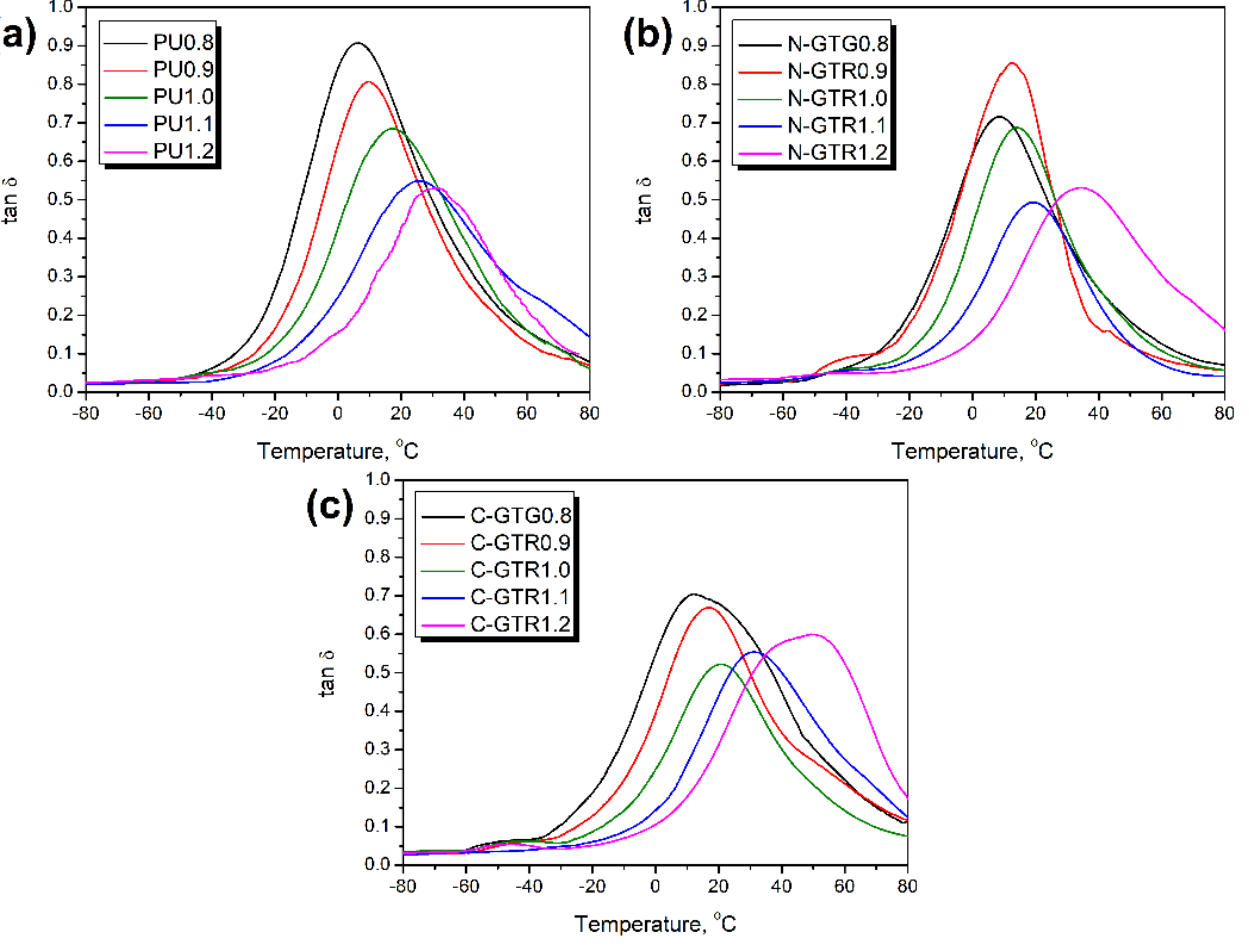
Figure 4. Temperature plots of loss tangent for ( a ) unfilled PU foams and PU/GTR composites prepared ( b ) without, and ( c ) with considering the hydroxyl values of GTR during formulation